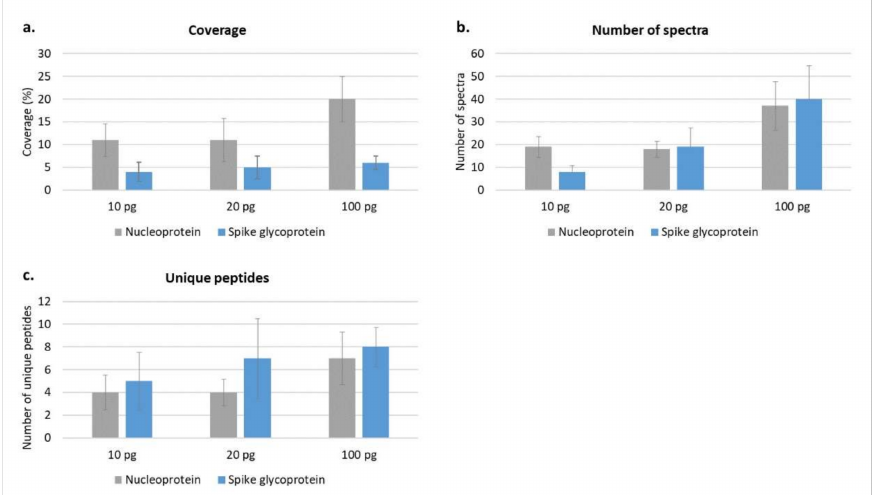
Figure 3. Correlation between the amount of purified viral proteins analysed and sequence coverage ( a ), number of spectra ( b ) and unique peptides ( c ). Bar charts showing the correlation between the amount of purified SARS-CoV-2 proteins (S1, S2, RBD and N) analysed and sequence coverage ( a ), number of spectra ( b ) and unique peptides ( c ) identified for the nucleoprotein and the spike glycoprotein. Standard deviations of the three replicates are also shown.